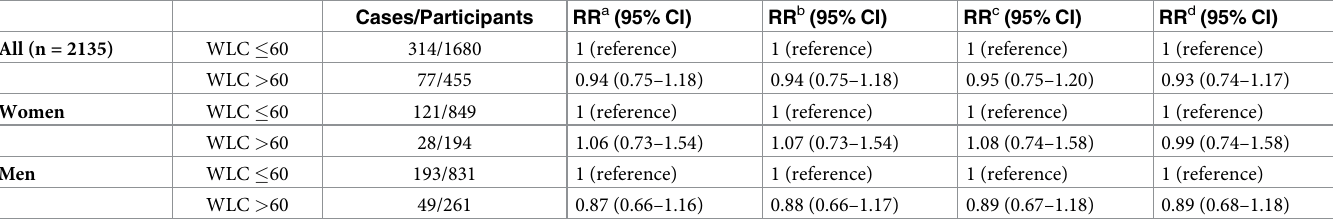
Table 2. Risk ratios (RR) and 95% confidence intervals (CI) for WLC and incident